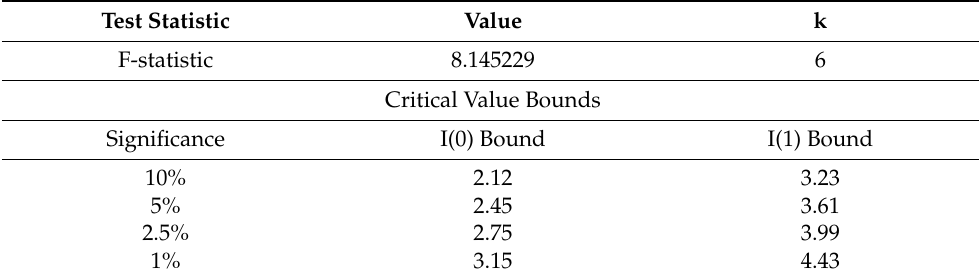
Table 9. NARDL Bound